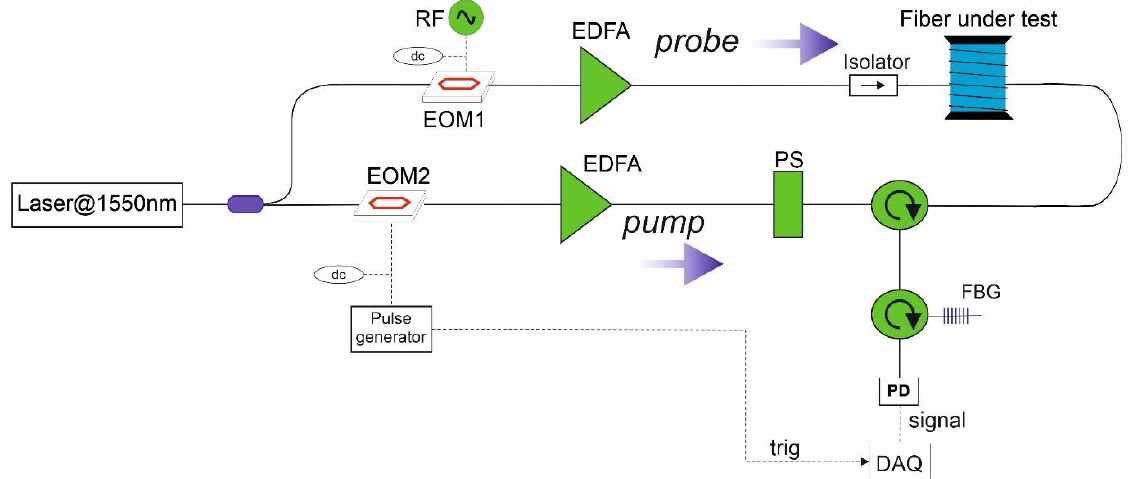
Figure 1. Experimental set-up for (BOTDA) Brillouin Optical Time-Domain Analysis measurements. (EOM) electro-optic modulator; (PS) polarization switch; (EDFA) erbium-doped fiber amplifier; (PD) photodetector; (FBG) fiber Bragg grating; (DAQ) data acquisition (redrawn from [21]).